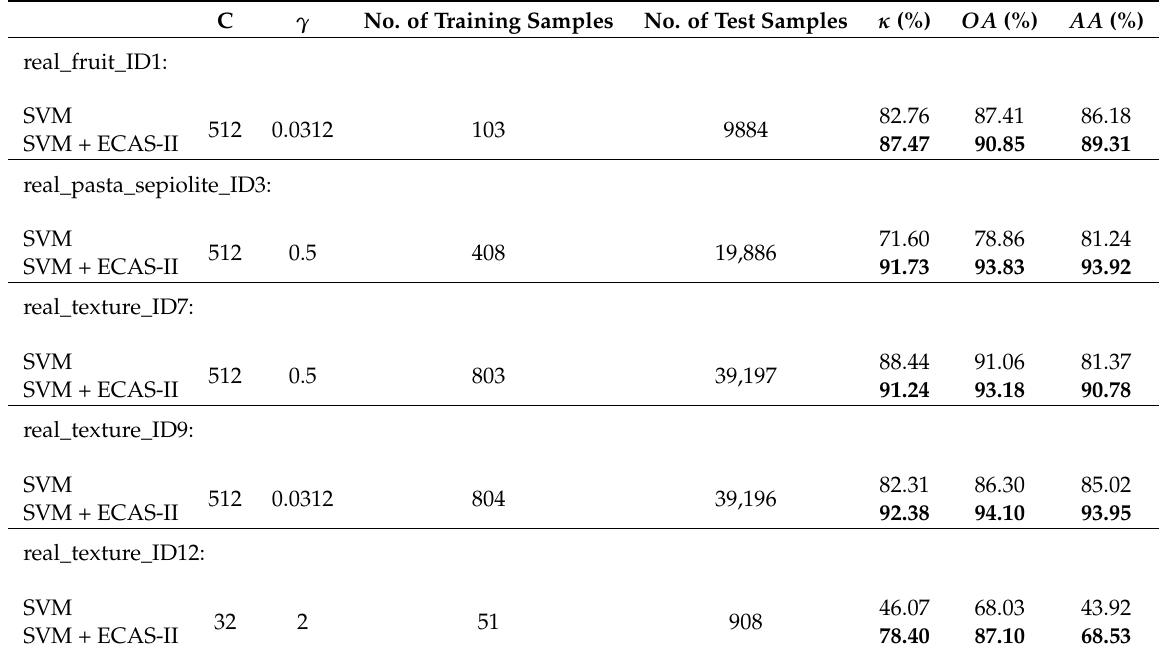
Table 4. Classification accuracies (%) for the raw SVM and the ECAS-II + SVM algorithm applied to real hyperspectral images from the GII-HSEG